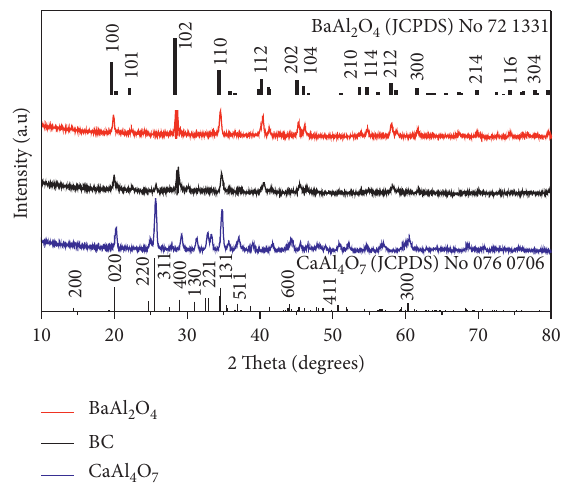
2 O 4 , BC, and CaAl 4 O 7